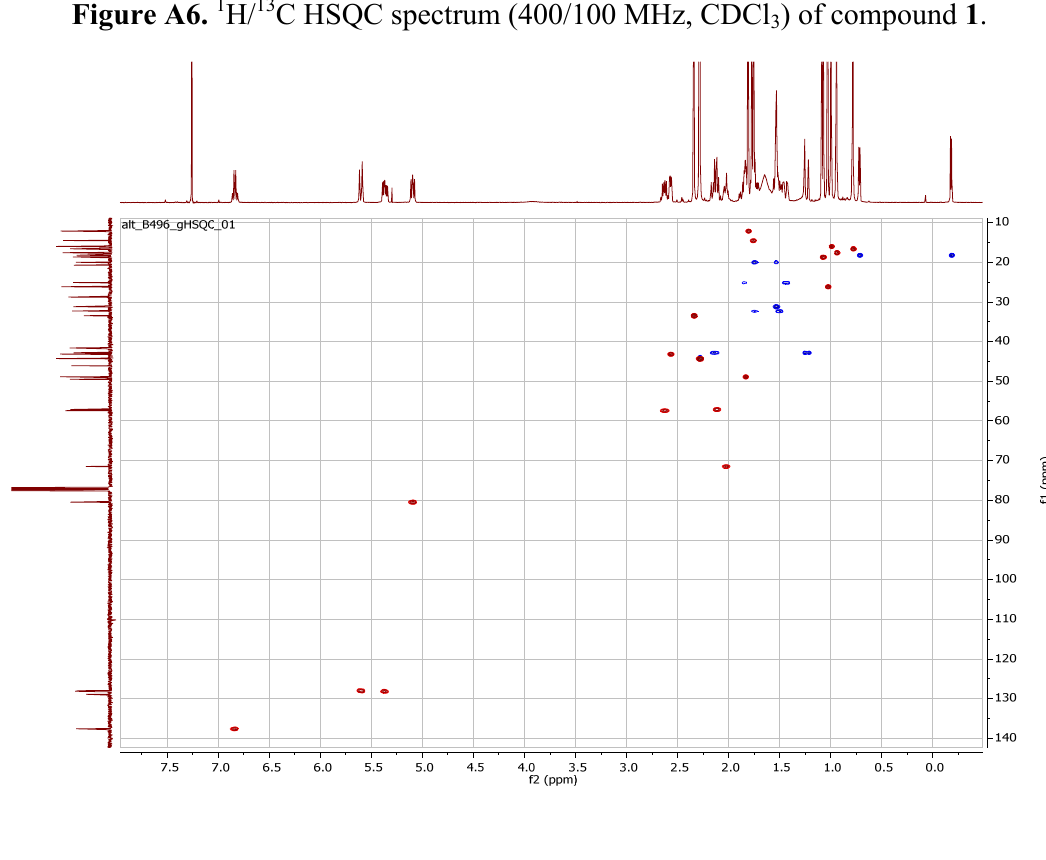
Figure A6. 1 H/ 13 C HSQC spectrum (400/100 MHz, CDCl